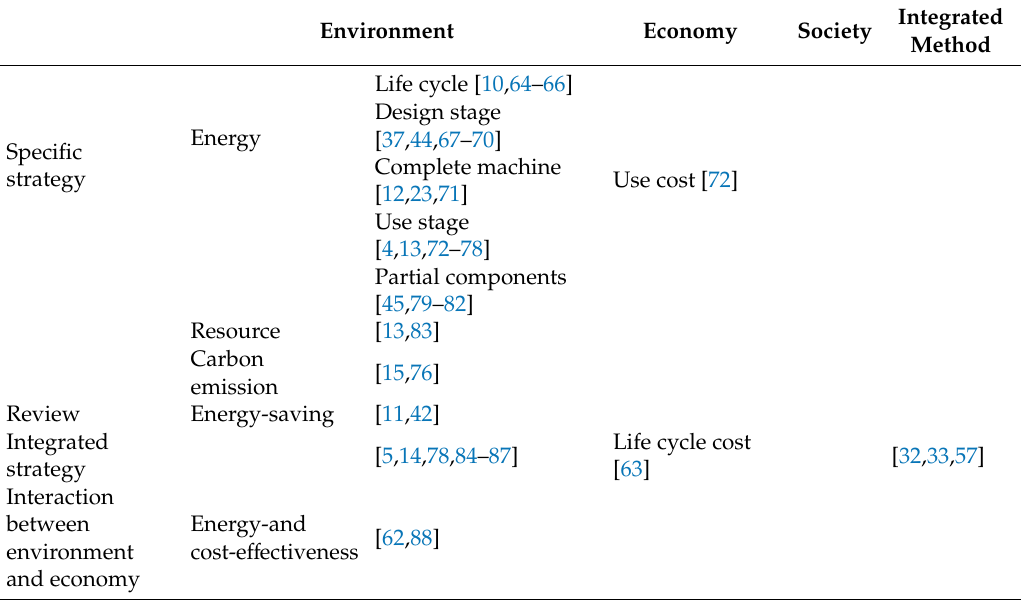
Table 2. The analysis result related to dimensions of sustainable machine tools.